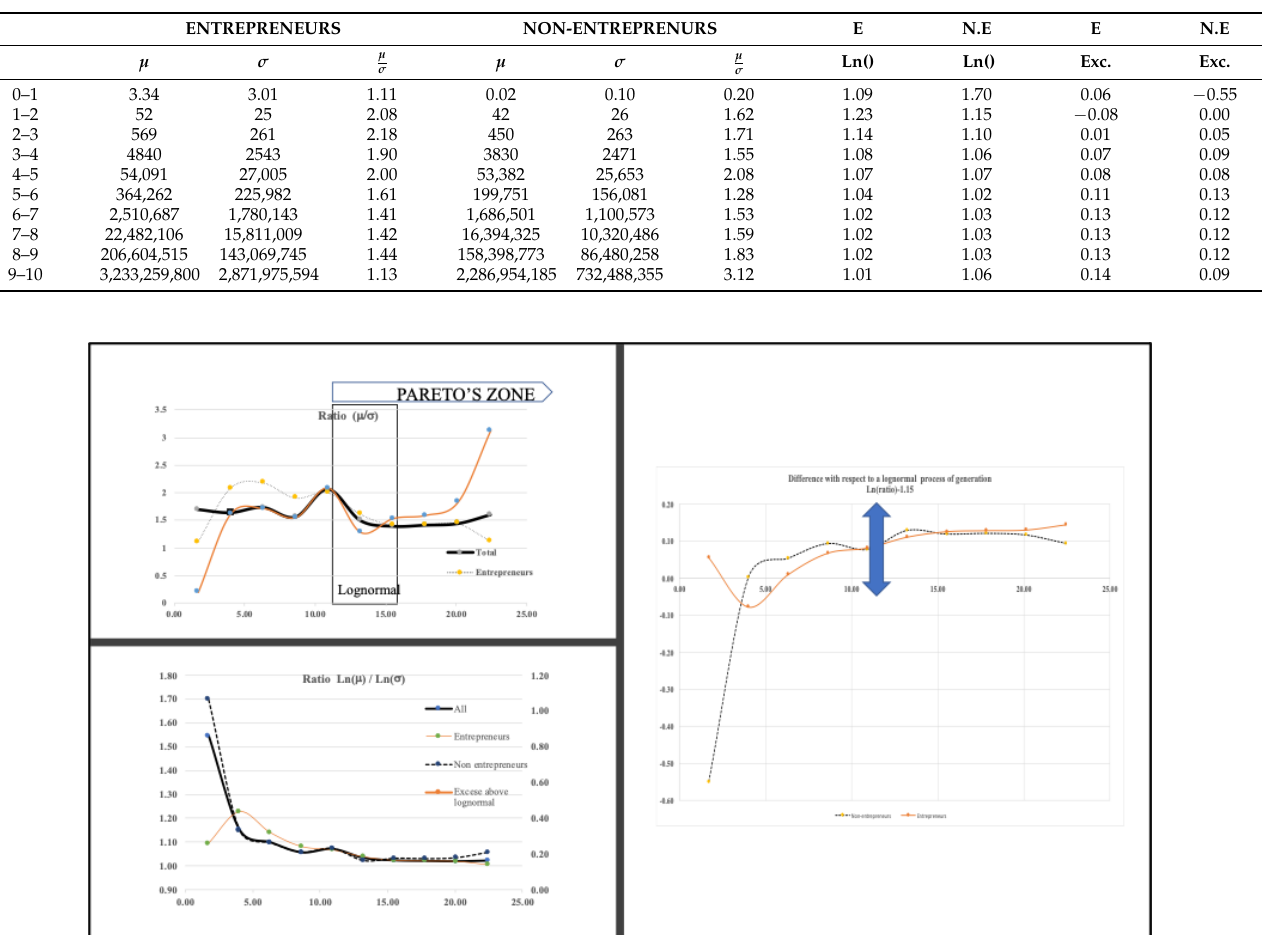
Table 6. Distribution by wealth intervals and subpopulations.